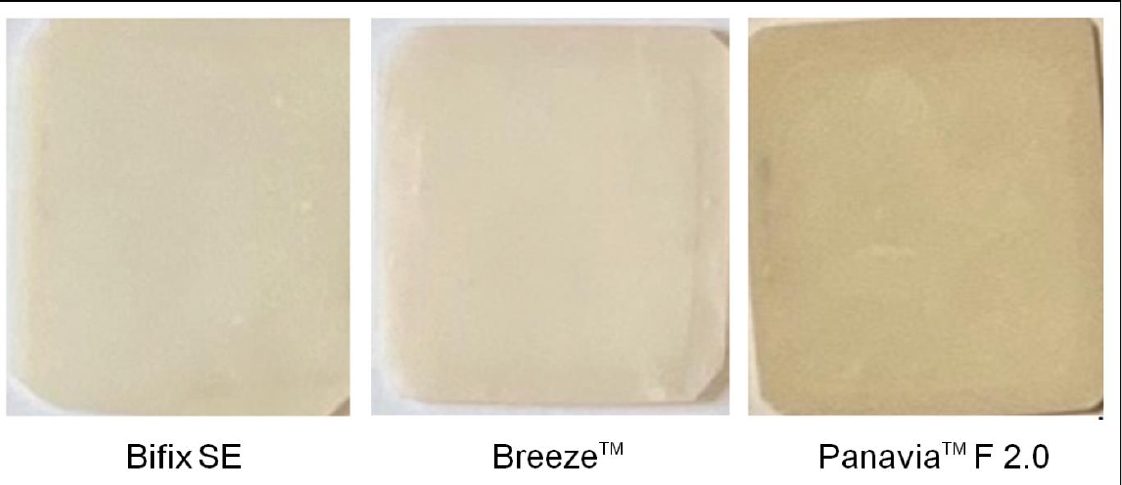
Figure 1. Sample specimen with a cement layer thickness of 200 µm, presented according to its perceived brightness of “light” (Bifix SE), over “medium” (Breeze TM ), to “dark” (Panavia TM F